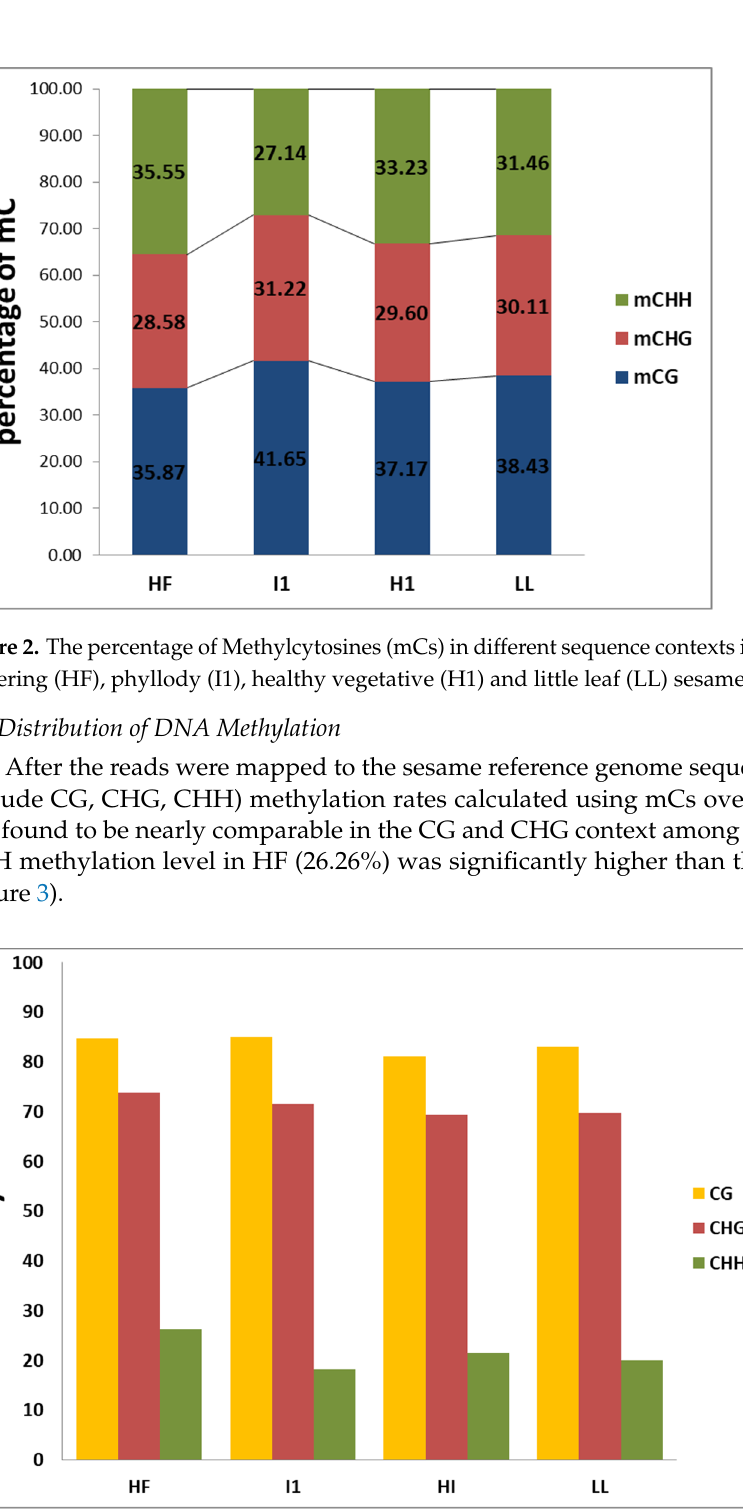
Figure 3. Percentage of Methylcytosines (mCs) over total CT count in CG, CHG and CHH contexts. HF-healthy flowering, I1-Phyllody-affected H1-healthy vegetative and LL-little leaf sesame sam- ples.